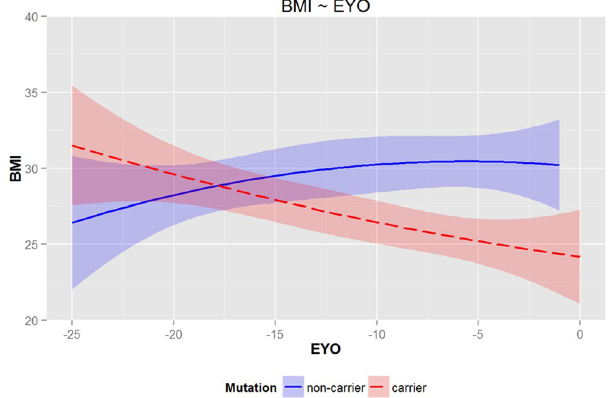
Figure 1. Cross sectional data (LOESS regression analysis and the estimates and their 95% confidence limits were drawn) of body-mass index (BMI) in preclinical (CDR = 0) mutation carriers (MCs) and non-mutation carriers (NCs) in relation to the estimated years to onset (EYO). A significant difference in BMI between MCs and NCs is detected in the area where the estimated 95% confidence intervals for the regression lines don’t overlap ( − 11.2 years). The intersection points of the lower and upper confidence interval borders were calculated by a numerical approximation. This method was also used to detect the point, at which the two curves begun to diverge ( − 17.8 years). The use of scatter plots is not permitted with DIAN data as the data points can be very specific to an individual and may allow to identify its mutation